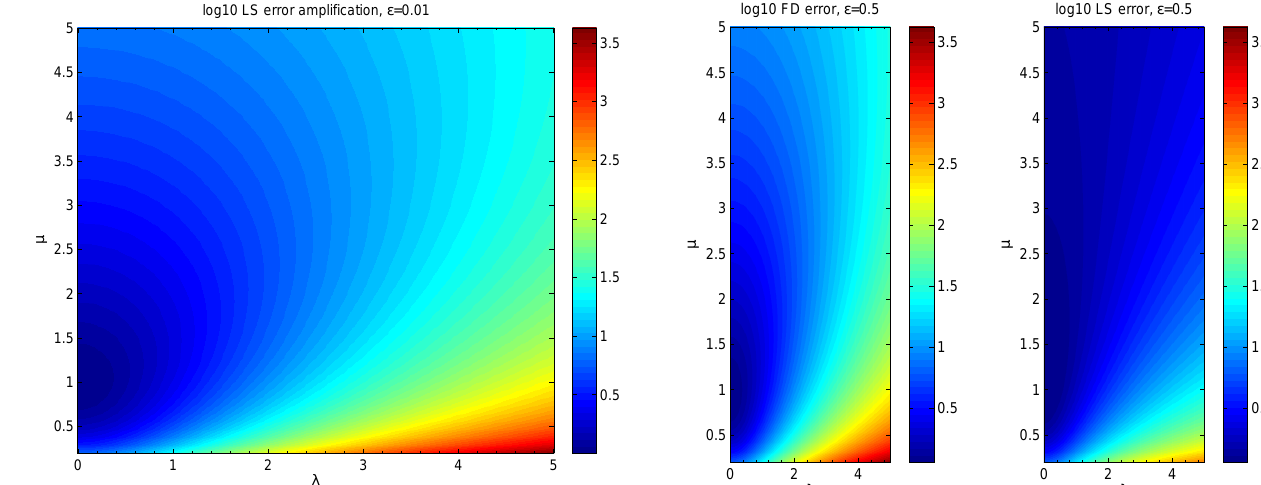
Fig. 4. Logarithms of the normalised error amplification factors ( P σ | p σ | 2 ) · ( P σ | r σ | 2 )/ 4 and ( P σ | q σ | 2 ) · ( P σ | r σ | 2 )/ 4 of the finite differences (left panel) and the least squares (right panel) pla- nar gradient estimators, respectively. Both error measures are given in terms of λ = ‘/L and µ = M/L and for ε = 0 .